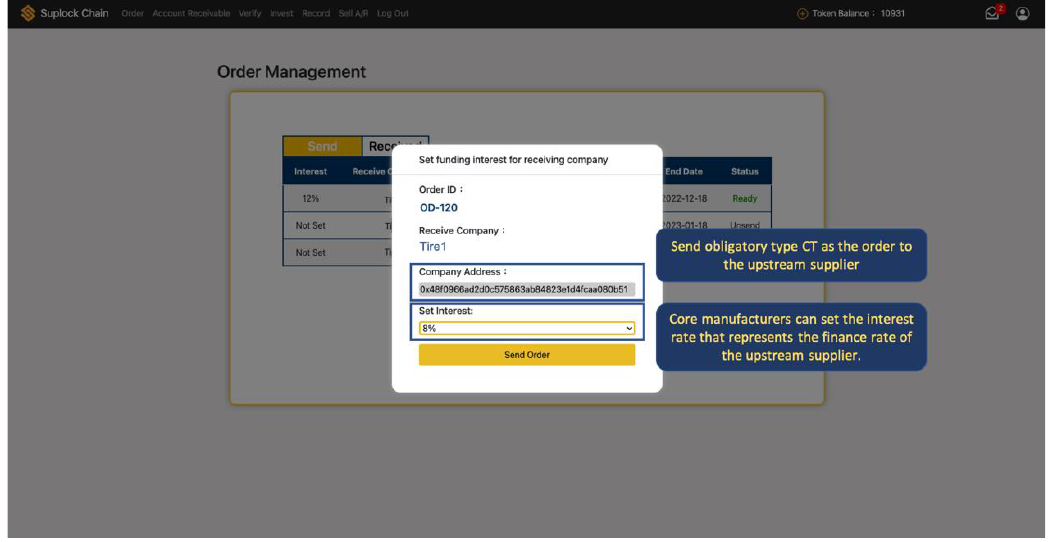
Figure A7. Module for minting conditional tokens. Core 1 issues order transaction to Tire1 on our website.